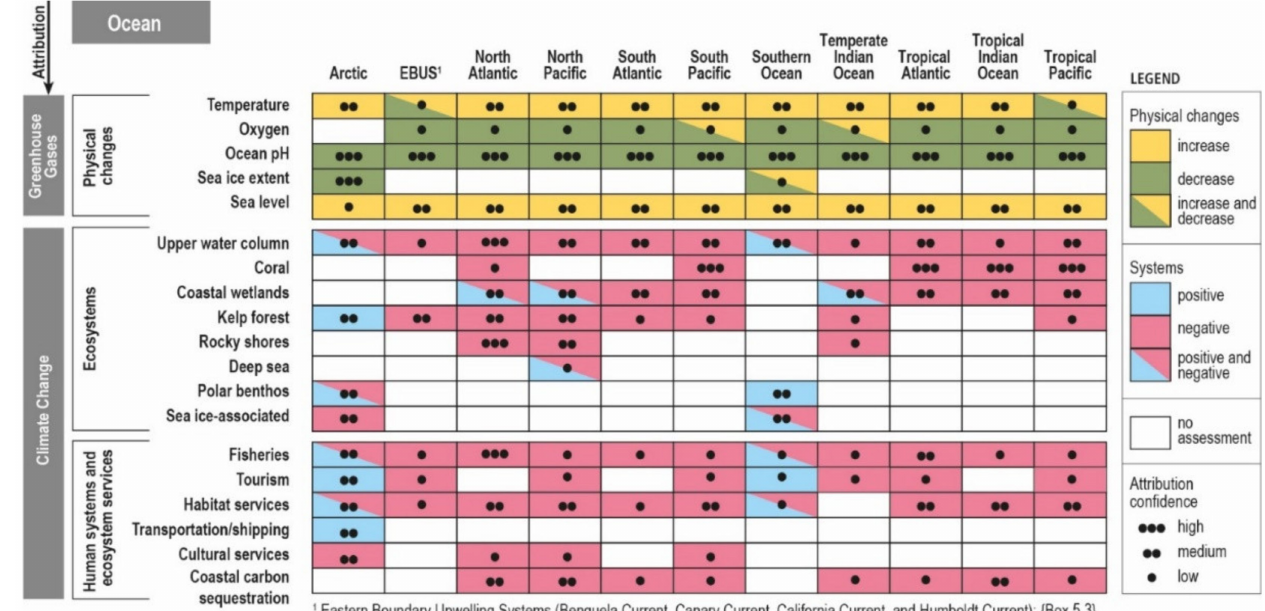
Figure 1. Synthesis of observed regional hazards and impacts in the ocean, assessed in the ‘Special report on the ocean and cryosphere in a changing climate’ (Figure 5.24 in the report). Detailed information about the legend and classification data are provided therein [4]. Many of these changes directly or indirectly influence the issue of ciguatera, as outlined in this